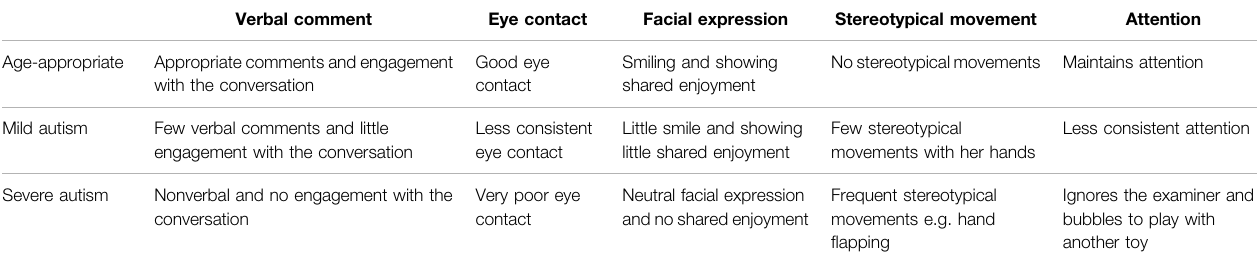
TABLE 1 | Summary of the designed verbal and nonverbal behaviors for each severity